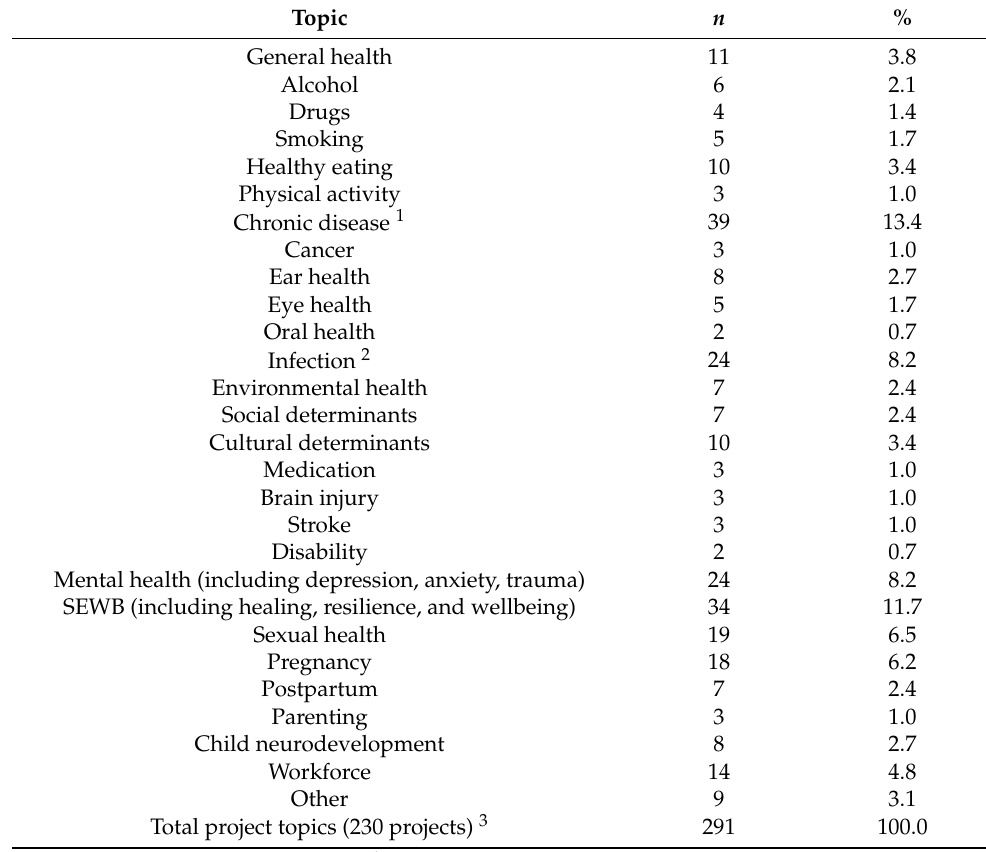
Table 3. Health topics of projects submitted to the KAHPF Research Subcommittee until end